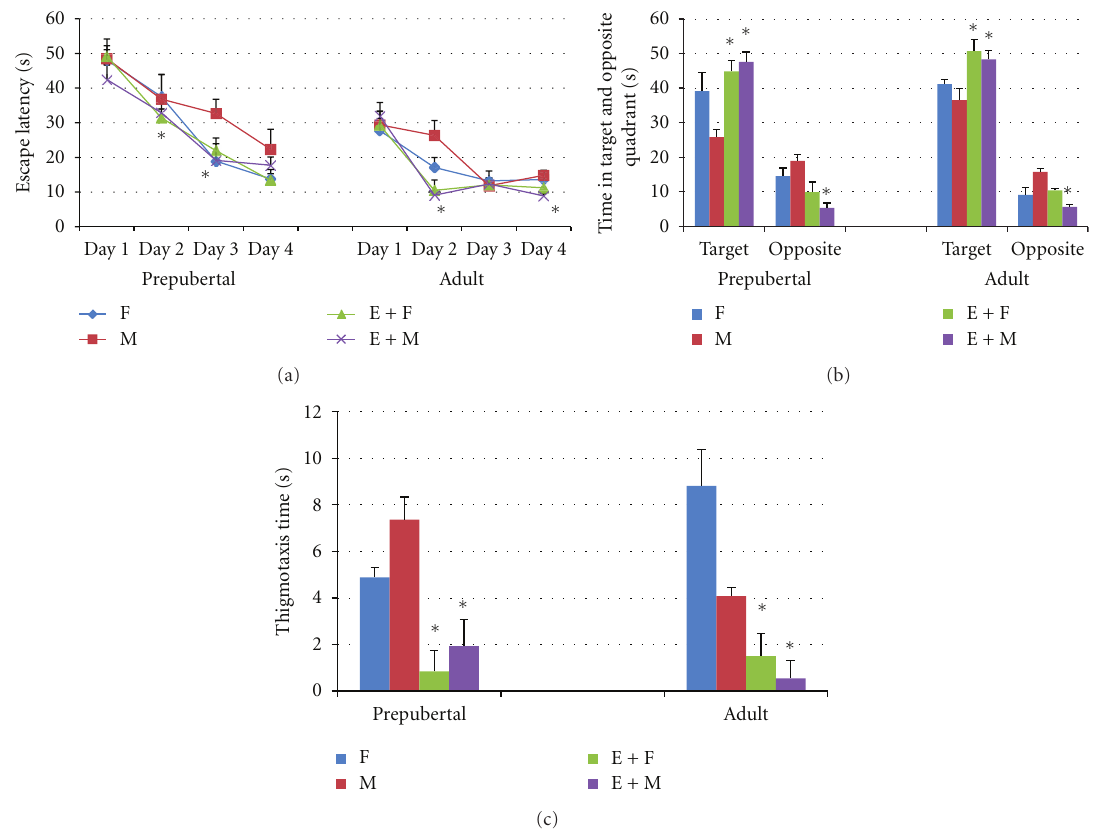
Figure 1: The Morris Water Maze performance of the groups. (a) The daily change in escape latency. (b) Time spent in the target and opposite quadrant in probe trial. (c) Thigmotaxis time in probe trial. ∗ P < 0 . 05 compared to the other groups. F: control female pups, M: control male pups, E + F: female pups whose mothers exercised during pregnancy, E + M: male pups whose mothers exercised during